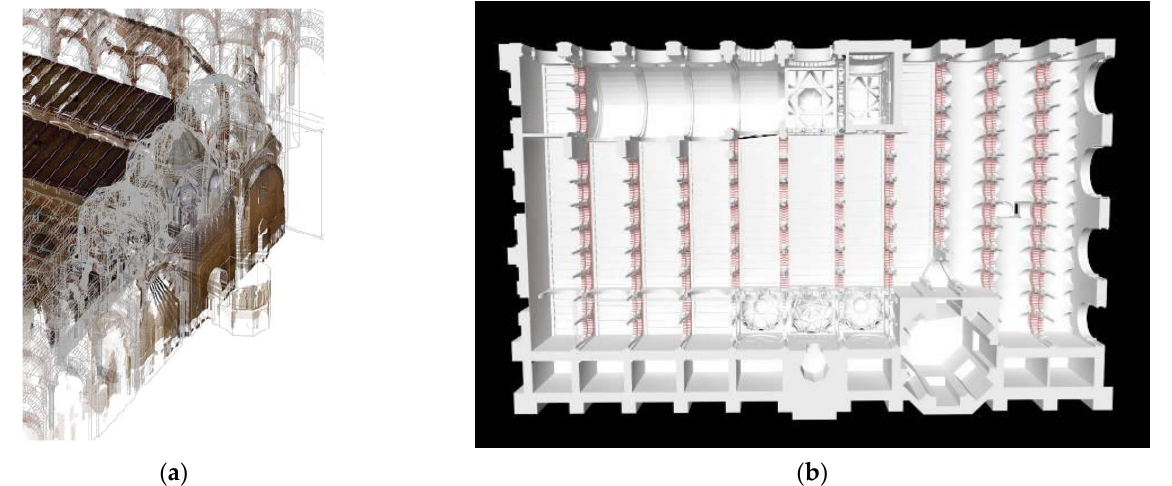
Figure 16. Detail from the Al-Hakam II expansion in the Mosque of Cordoba: ( a ) Overlapping between the geometric model and the point cloud; ( b ) 3D geometric model derived from the point cloud (view from bottom). Source: Own images. 2.4. Location of Viewpoints and Horizon lines; Prangey’s Viewpoints and 3D Model Overlapping